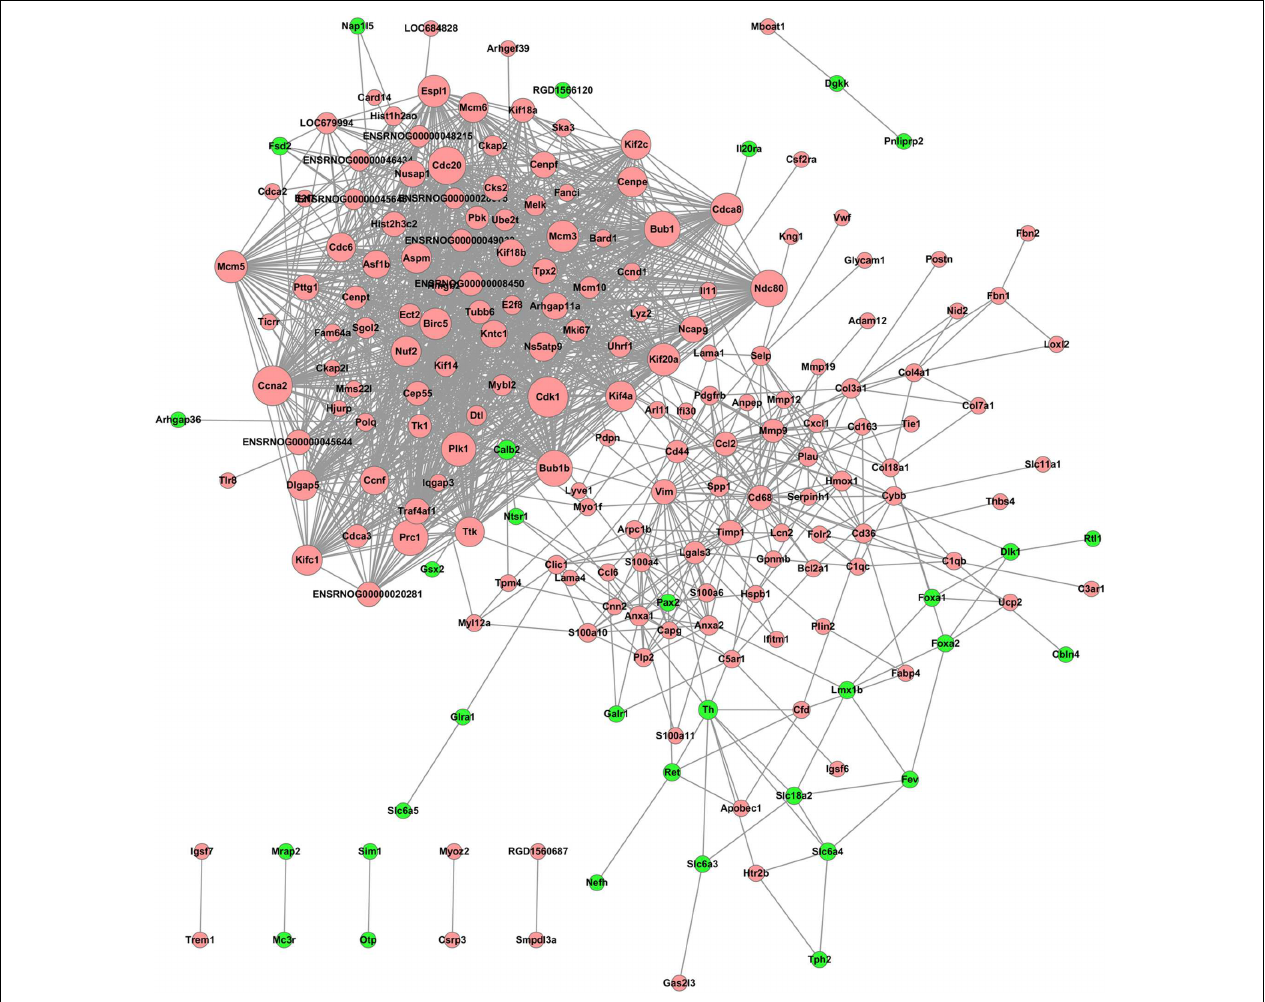
FIGURE 5 | PPI network of the DEGs resulting from THSWD treatment of MCAO. Node sizes correlate with node importance; Pink nodes denote up-regulated genes, while green nodes denote down-regulated genes; PPI, protein–protein interaction; DEGs, differentially expressed genes.